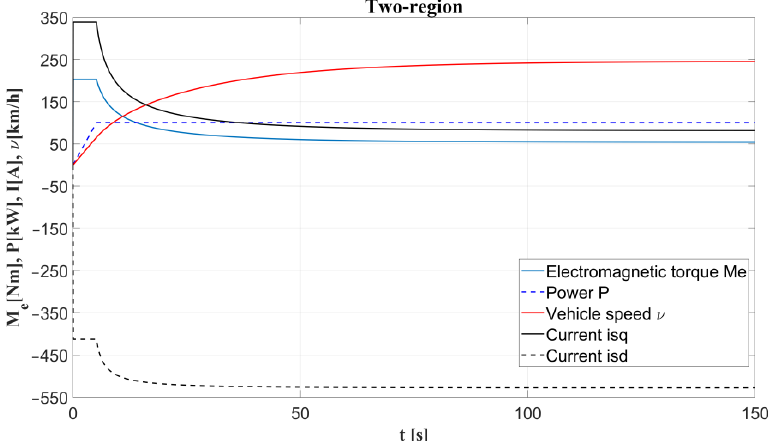
Figure 12. Performance of the Fisker Karma with two 100 kW IPMSMs. Dynamics of the two-region motor torque control.